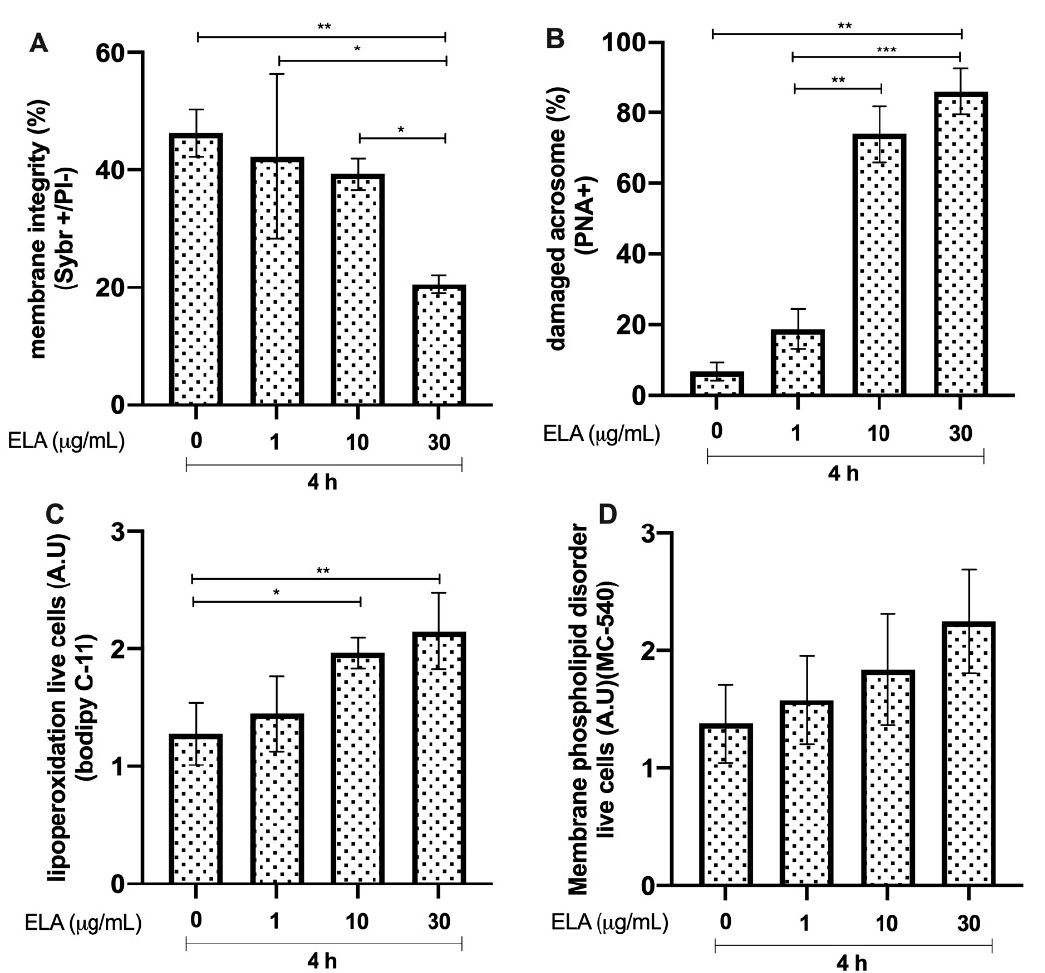
Figure 4. Effect of different concentrations of neutrophil elastase (ELA) on bull sperm. ( A ) Plasma membrane integrity. ( B ) Damaged acrosomes. ( C ) Lipid peroxidation. ( D ) Membrane phospholipid disorder. The results are shown as the mean ± standard deviation. The asterisks (*, **, ***) above the bars indicate differences between the groups ( p < 0.05, p < 0.01, and p < 0.0001) based on three bio- logical replicates.